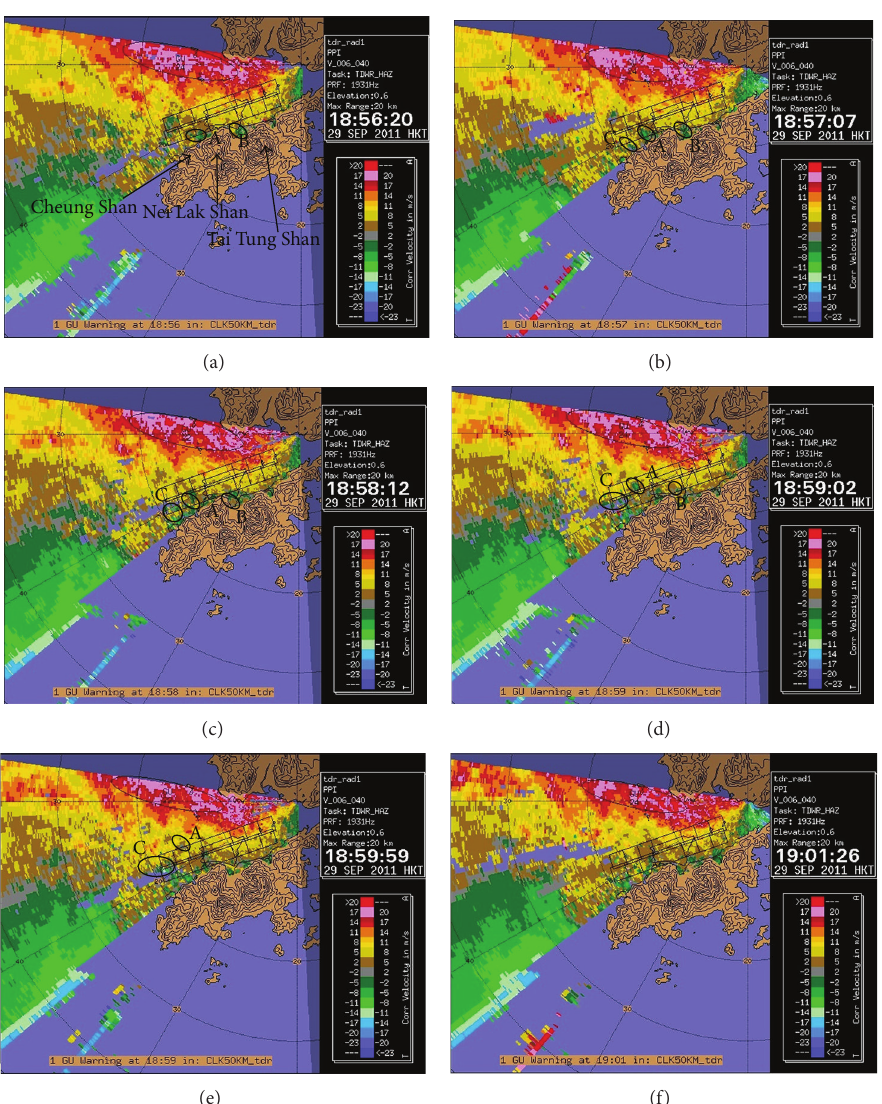
Figure 3: Radial wind speed observations from Doppler radar near Lantau Island ((a) represents 18:56 with 1-minute intervals between each